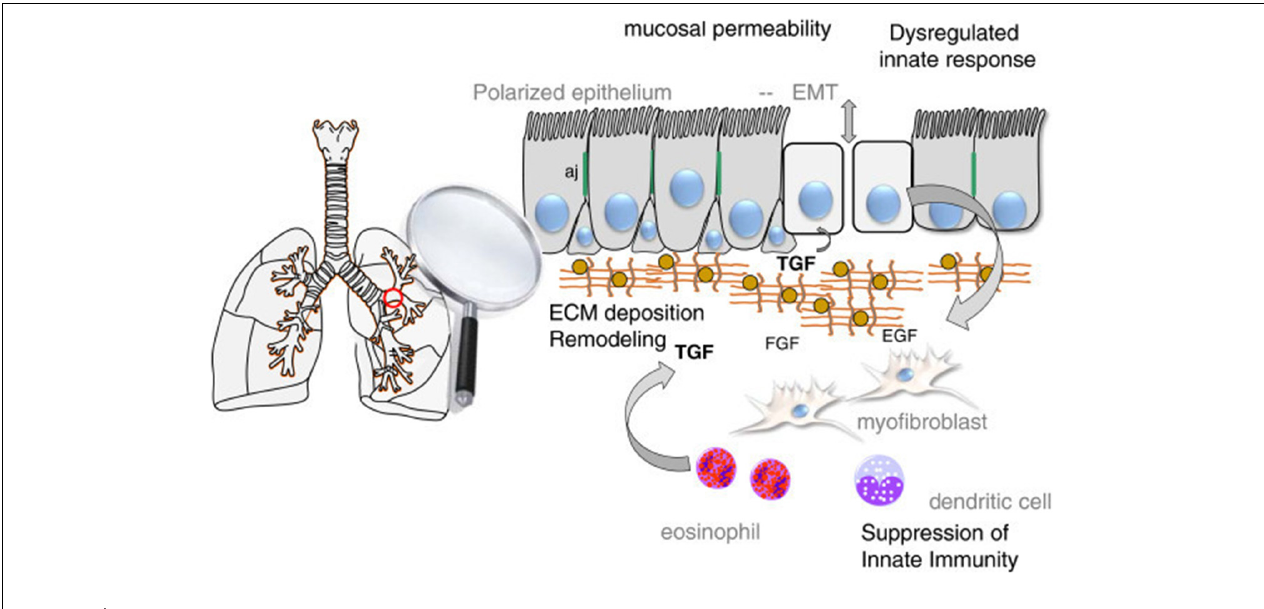
FIGURE 4 | Schematic view of EMT in the